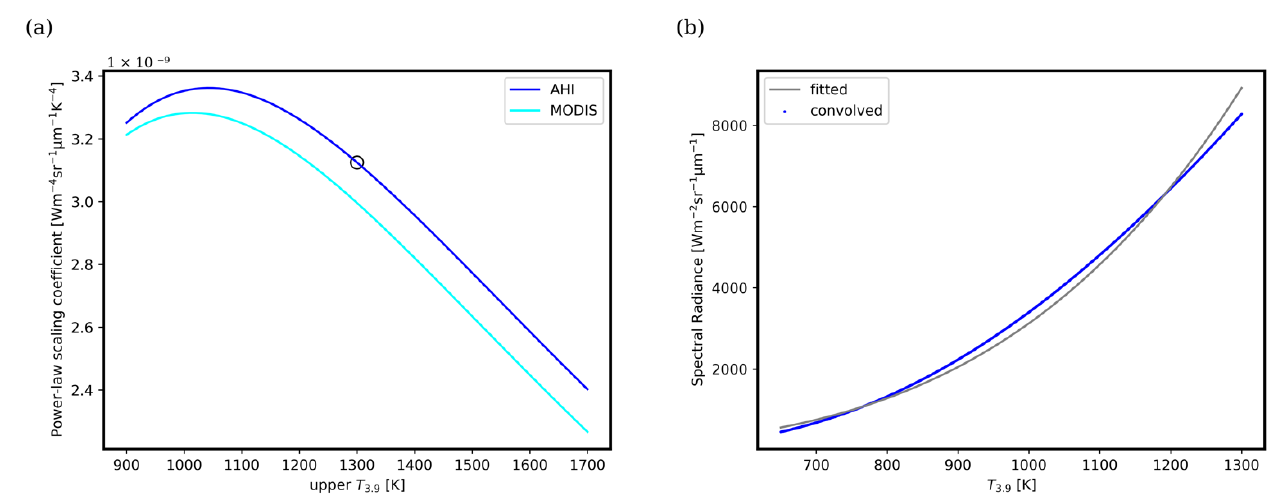
Figure 1. ( a ) Power-law scaling coefficients per upper MIR fitted for AHI (3.9 μm ; channel #7) (dark blue) and MODIS (3.9 μm ; channel #21) (light blue). ( b ) The approximated spectral radiances for AHI (3.9 μm ; channel #7) calculated using MIR range of 650 K to 1300 K (in 1 K intervals), along with the convolved Planck’s Law and AHI SRF (blue). (The black circle shown in ( a ) shows the AHI power-law scaling coefficient in ( b )). Table 1. Number of all matched hotspots in year-long Australia-wide sample, along with the respective number of matched hotspots calculated using saturated MIR values (in terms of count and percentage of the total count), where polar means MODIS or VIIRS, and geo means BRIGHT/AHI. Total